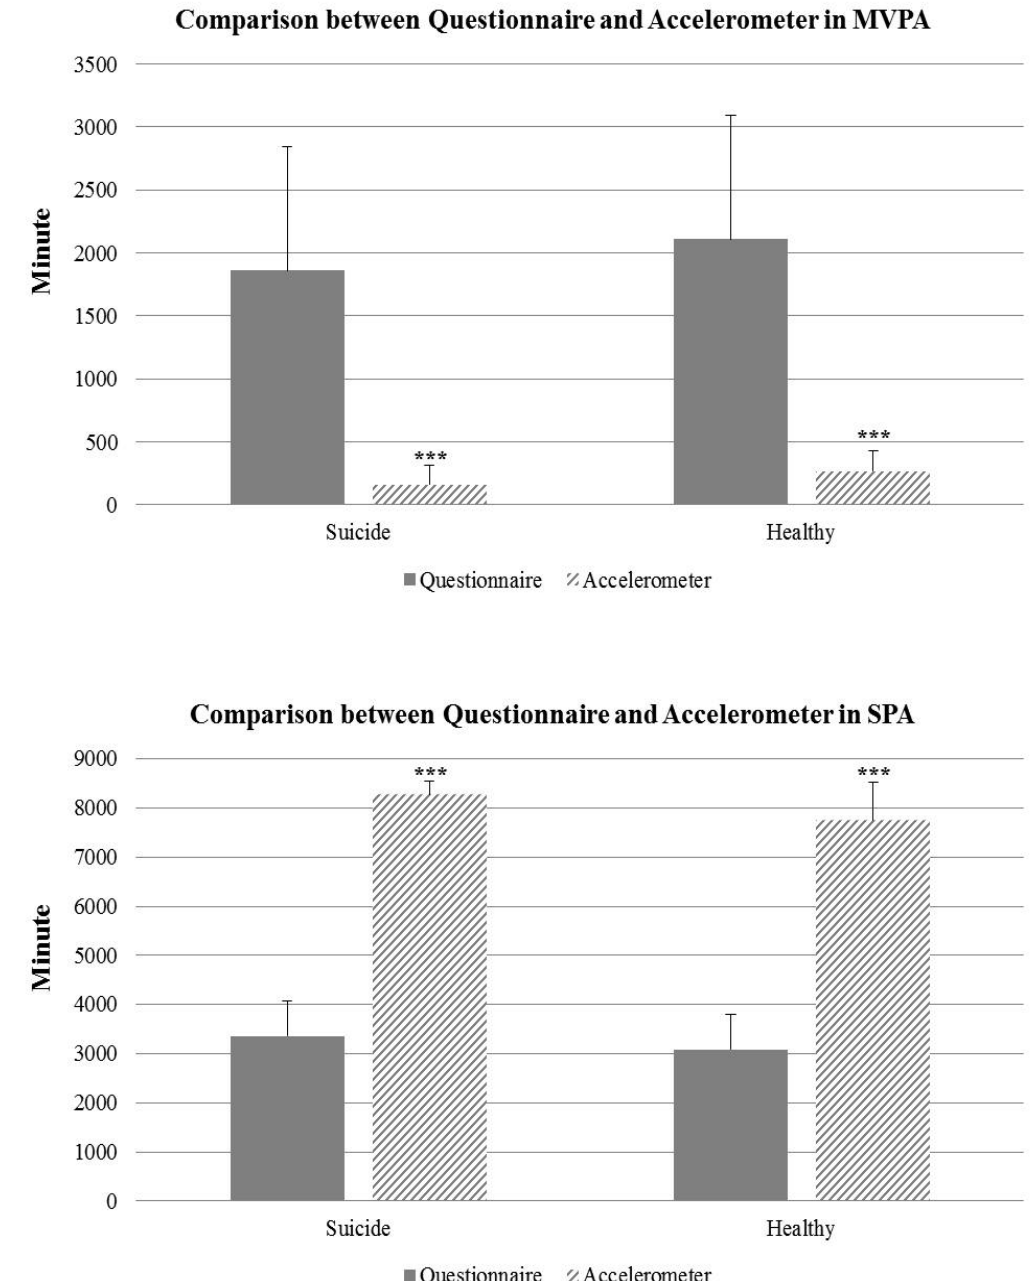
Figure 2. Comparison of participation time in physical activity calculated by the questionnaire and accelerometer during a week between the suicide and healthy groups. The significant differences between the two groups. *** < 0.001, Error bars represent the 95% confidence interval. MVPA: moderate to vigorous physical activity, SPA: sedentary physical activity.